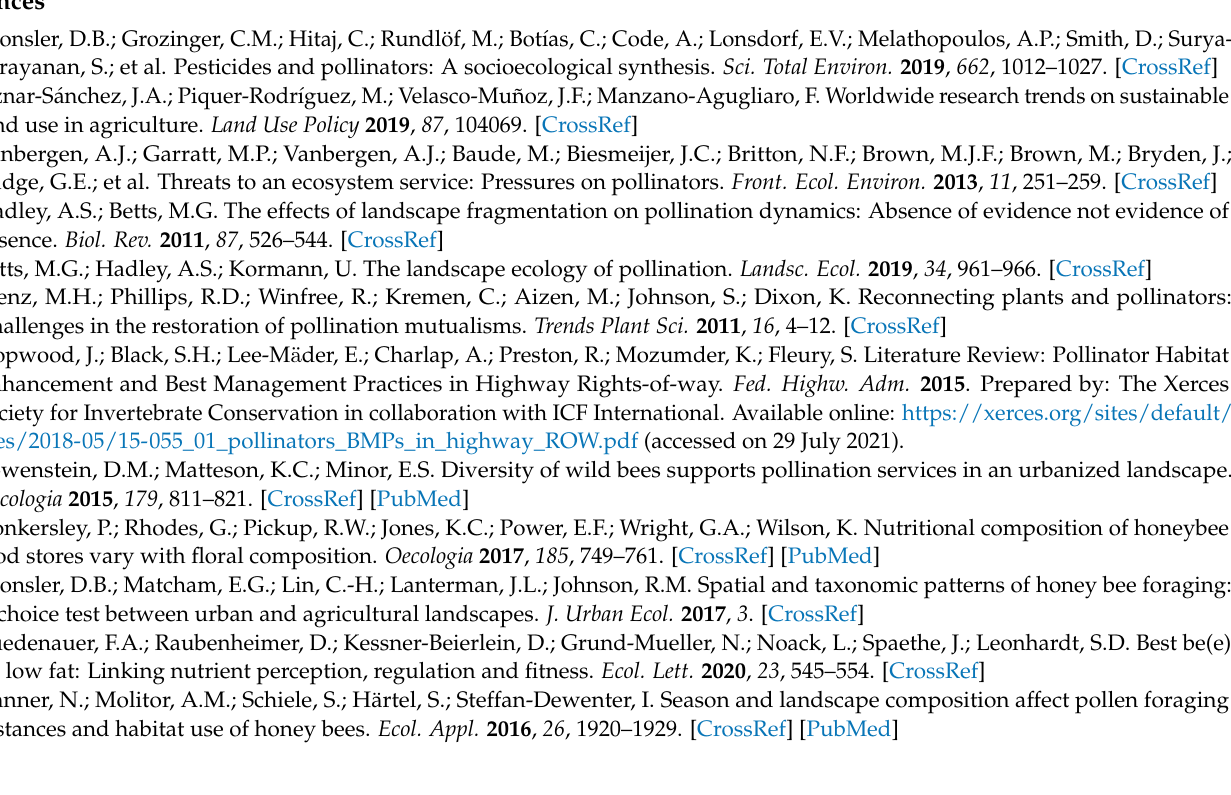
Table S2. The land types used to classify vegetation cover across Nagasaki and Saga provinces of Japan. Figure S1. Proportion of fructose, maltose and glucose in honey samples collected from five Apis cerana japonica hives in Nagasaki, Japan; Figure S2. Proportion of land uses in a 1 km radius surrounding five Apis cerana japonica hives in Nagasaki, Japan. Supplementary materials: Questionnaire